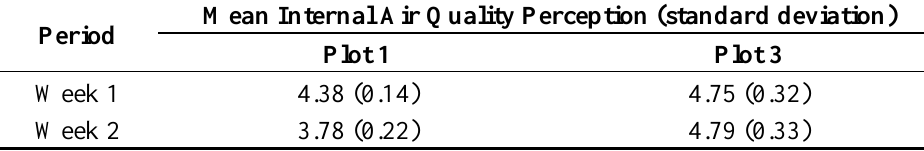
Table 5. Mean occupant internal air quality perception,